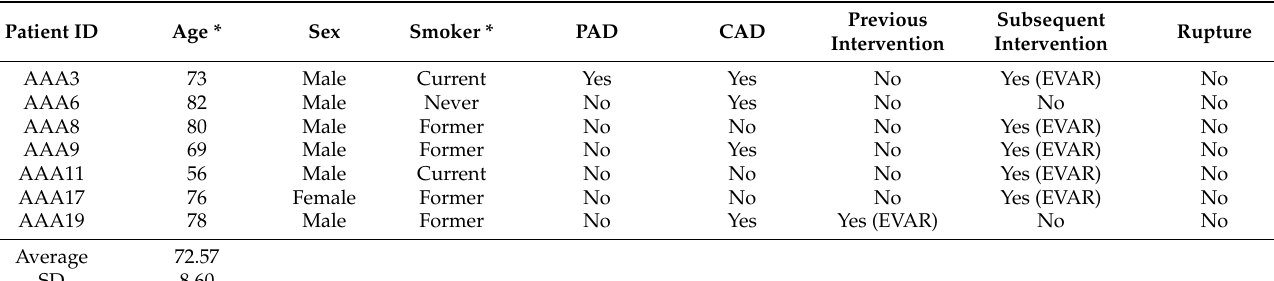
Table 1. Patient Demographics.